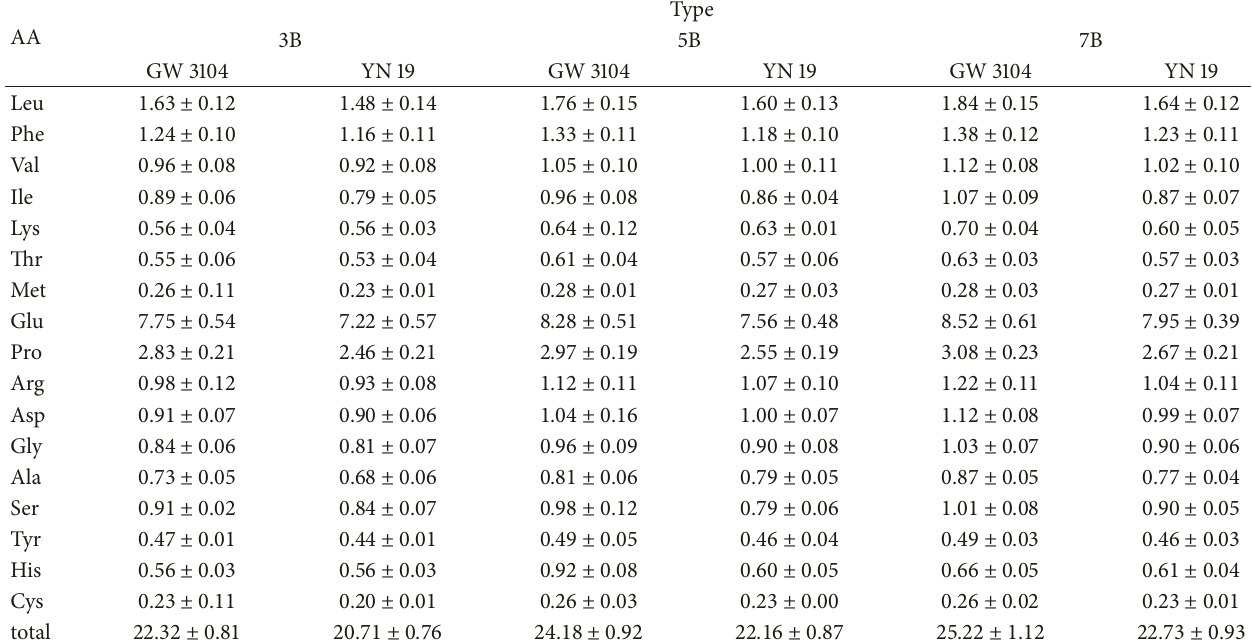
Table 3: Amino acid compositions of different wheat milling methods (%).